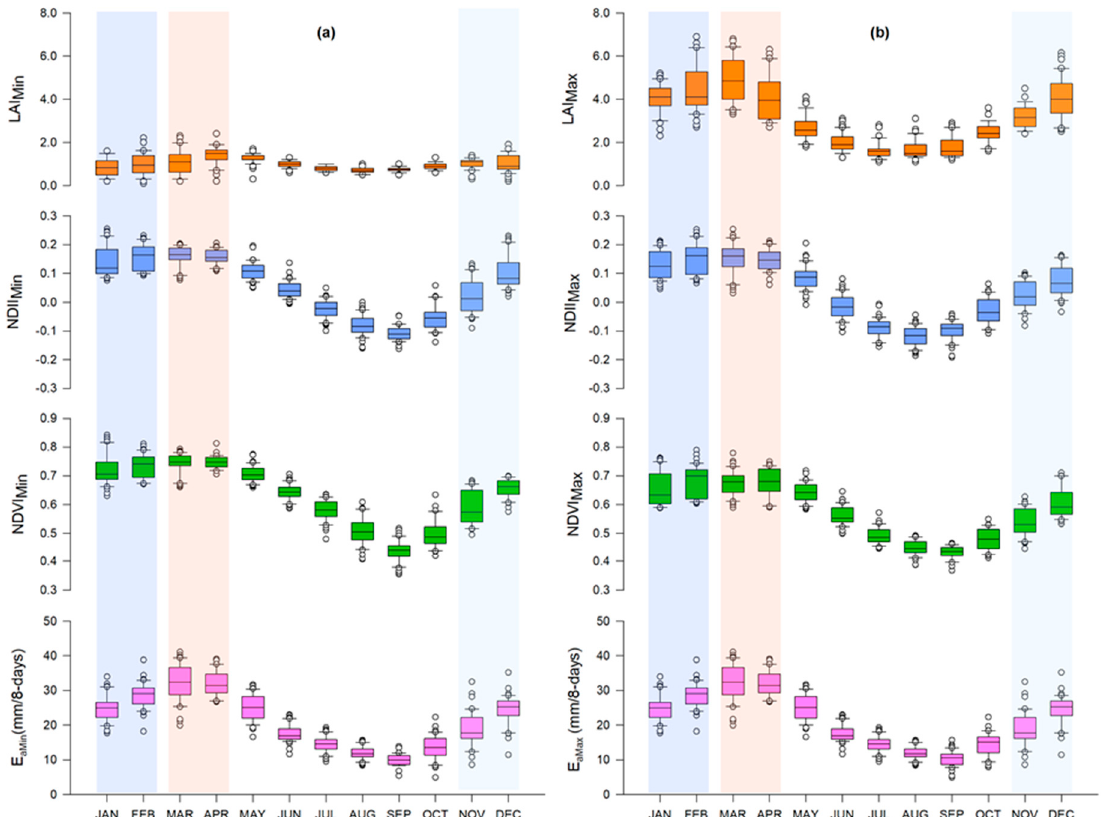
Figure 4. 2009–2018 January to December minimum ( a ) and maximum ( b ) values of E a , LAI, NDII, and